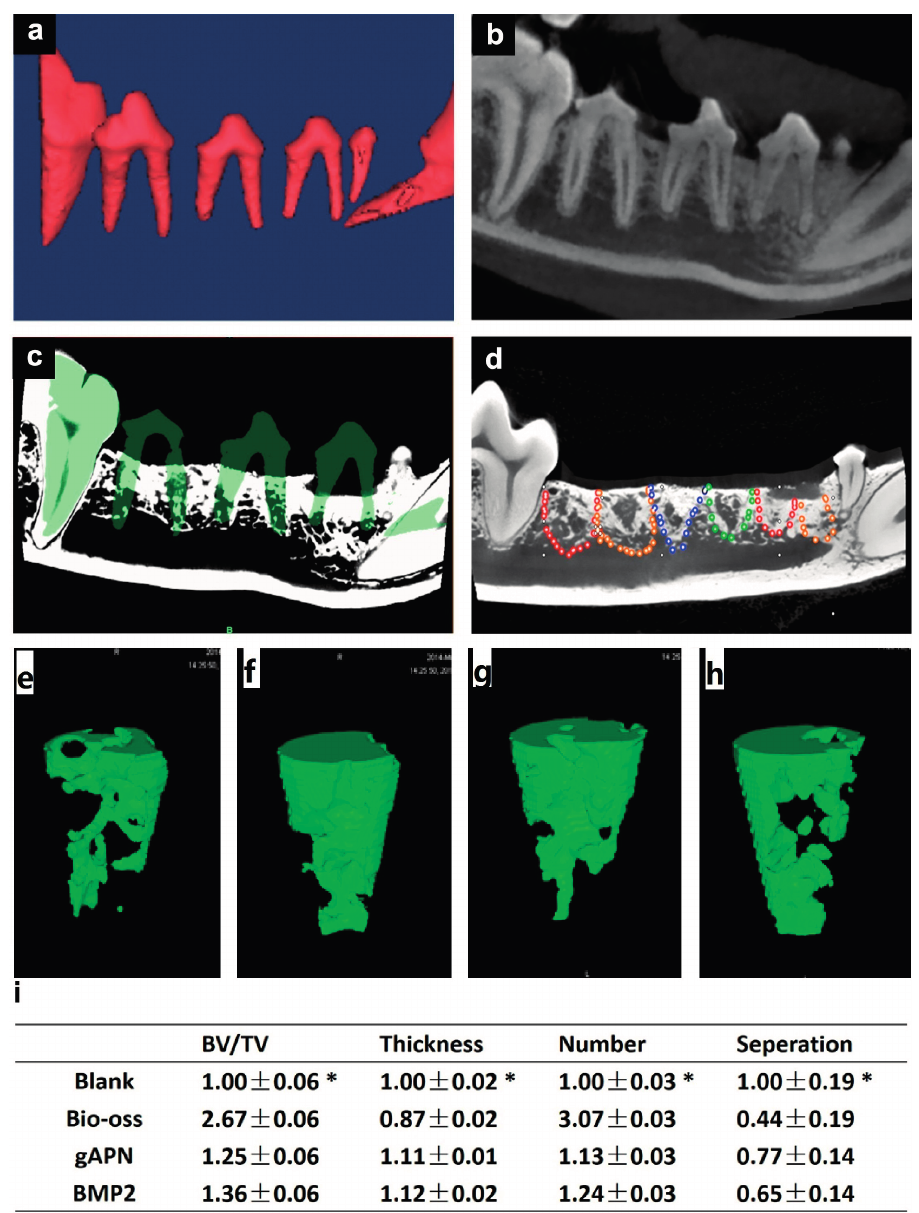
Figure 2. Extraction socket location and μ CT analysis: ( a ) 3D CBCT (Cone Beam Computed Tomography) reconstructions and ( b ) the teeth used for reference; ( c ) Superimposition 3D CBCT and μ CT models; ( d ) Highlighted borderline of the extraction socket in the μ CT models (red: gAPN-treated group, orange: BMP2-treated group, blue: Bio-Oss group, green: blank group). Representative 3D reconstruction of the trabecular structure in the extraction socket: ( e ) Blank; ( f ) Bio-oss; ( g ) gAPN and ( h ) BMP2; and ( i ) Changes in trabecular bone parameters, including trabecular bone volume normalised by tissue volume (BV/TV), trabecular thickness (Tb.Th), trabecular number (Tb.N), and trabecular separation (Tb.Sp) are shown as means ± SD, with n = 4. * p < 0.05, as determined by one-way